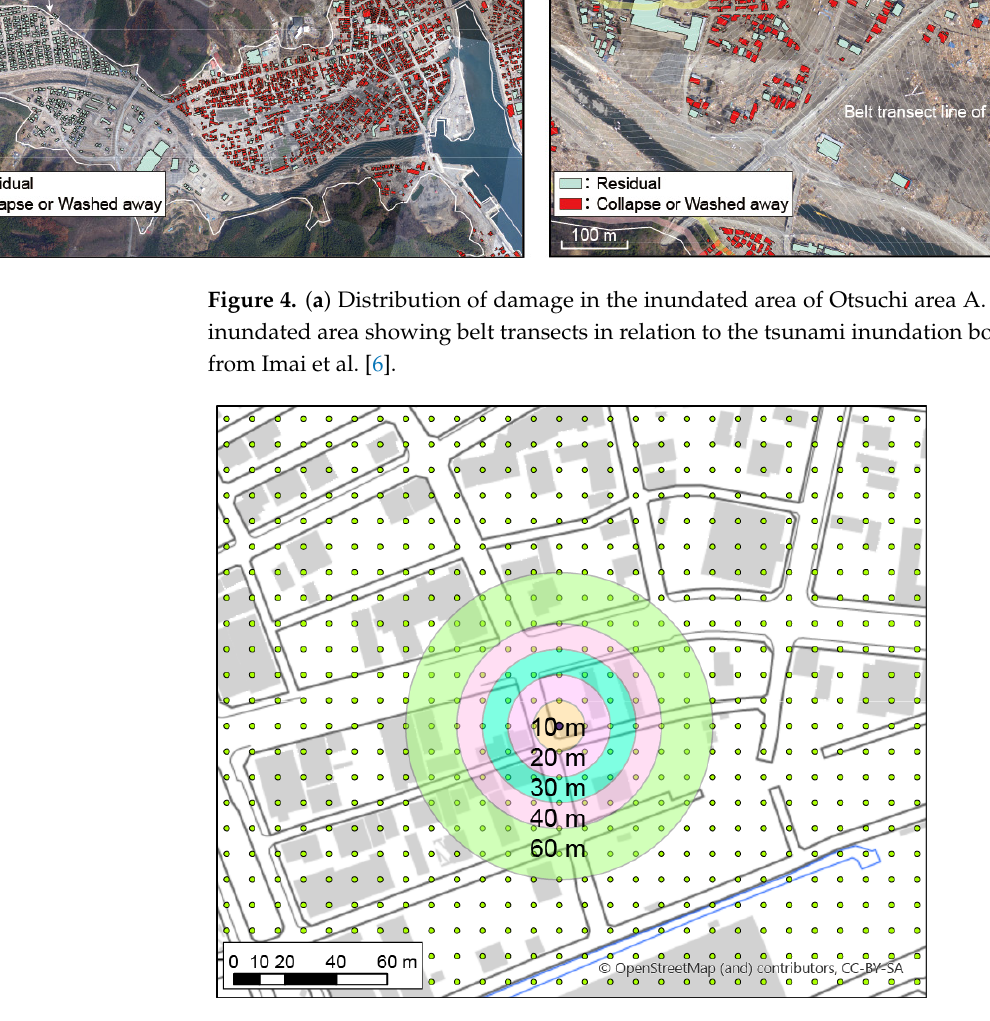
Figure 5. The definition sketch of SI evaluation. The presence or absence of buildings within a radius of 10 to 60 m, centered on an arbitrary point, is indexed within the range of 0 < SI < 2.25. Table 1. Volume of residual accumulated debris; estimated debris volume from washed away and totally destroyed buildings; its residual